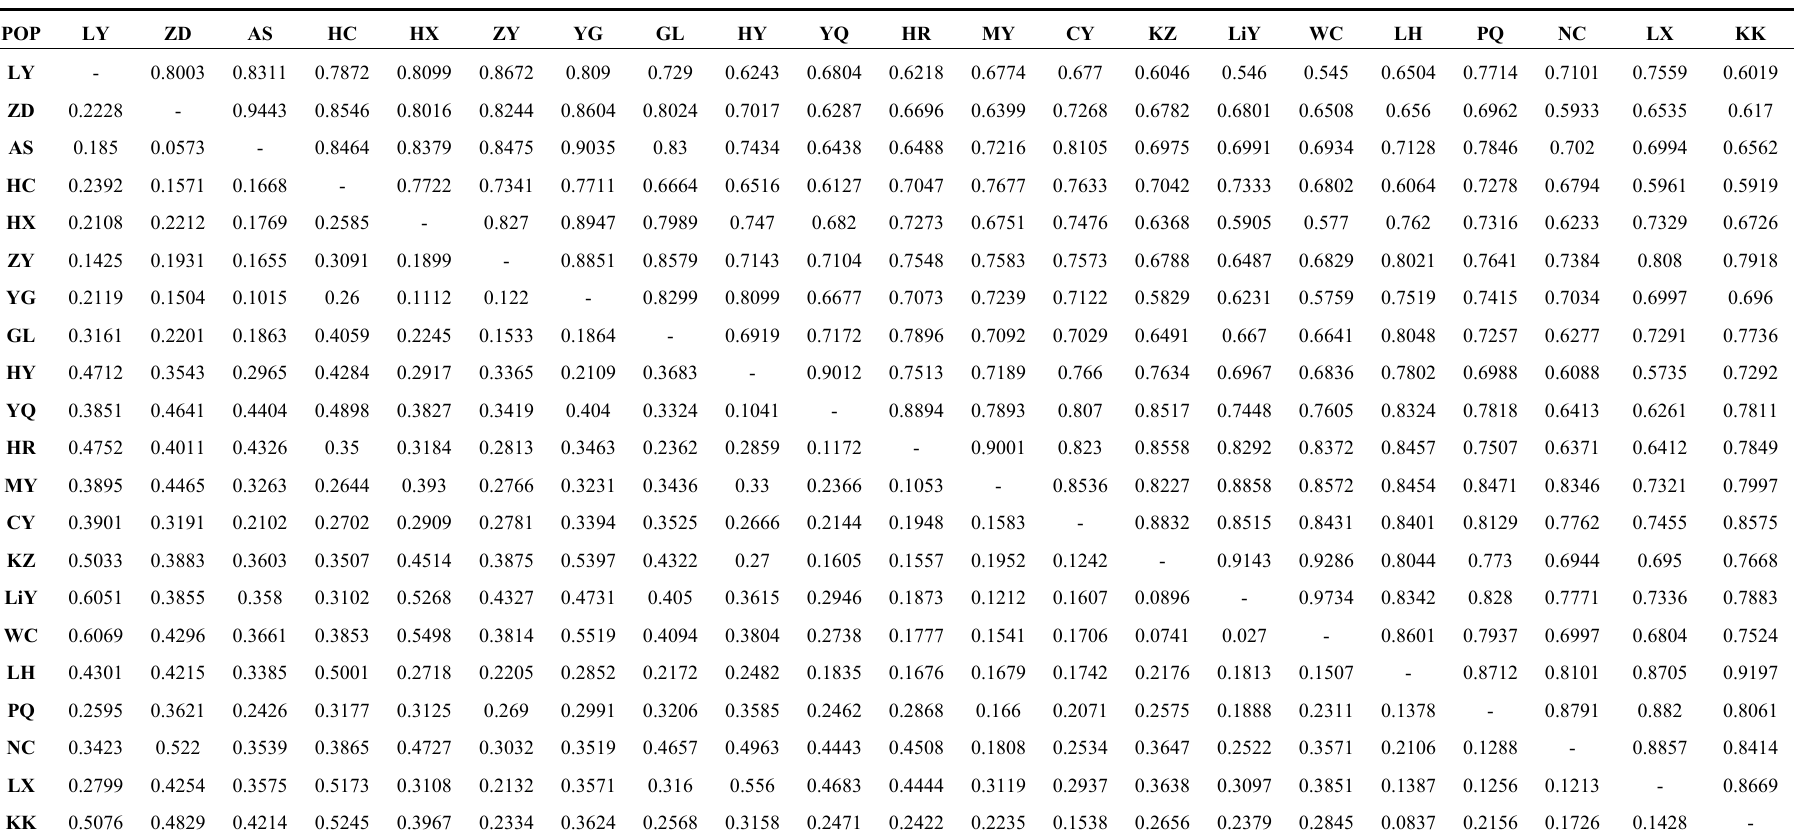
Table S5. Nei’s (1978) unbiased genetic identity (above diagonal) and genetic distance (below diagonal) among Siberia apricot populations reveled by SSR markers